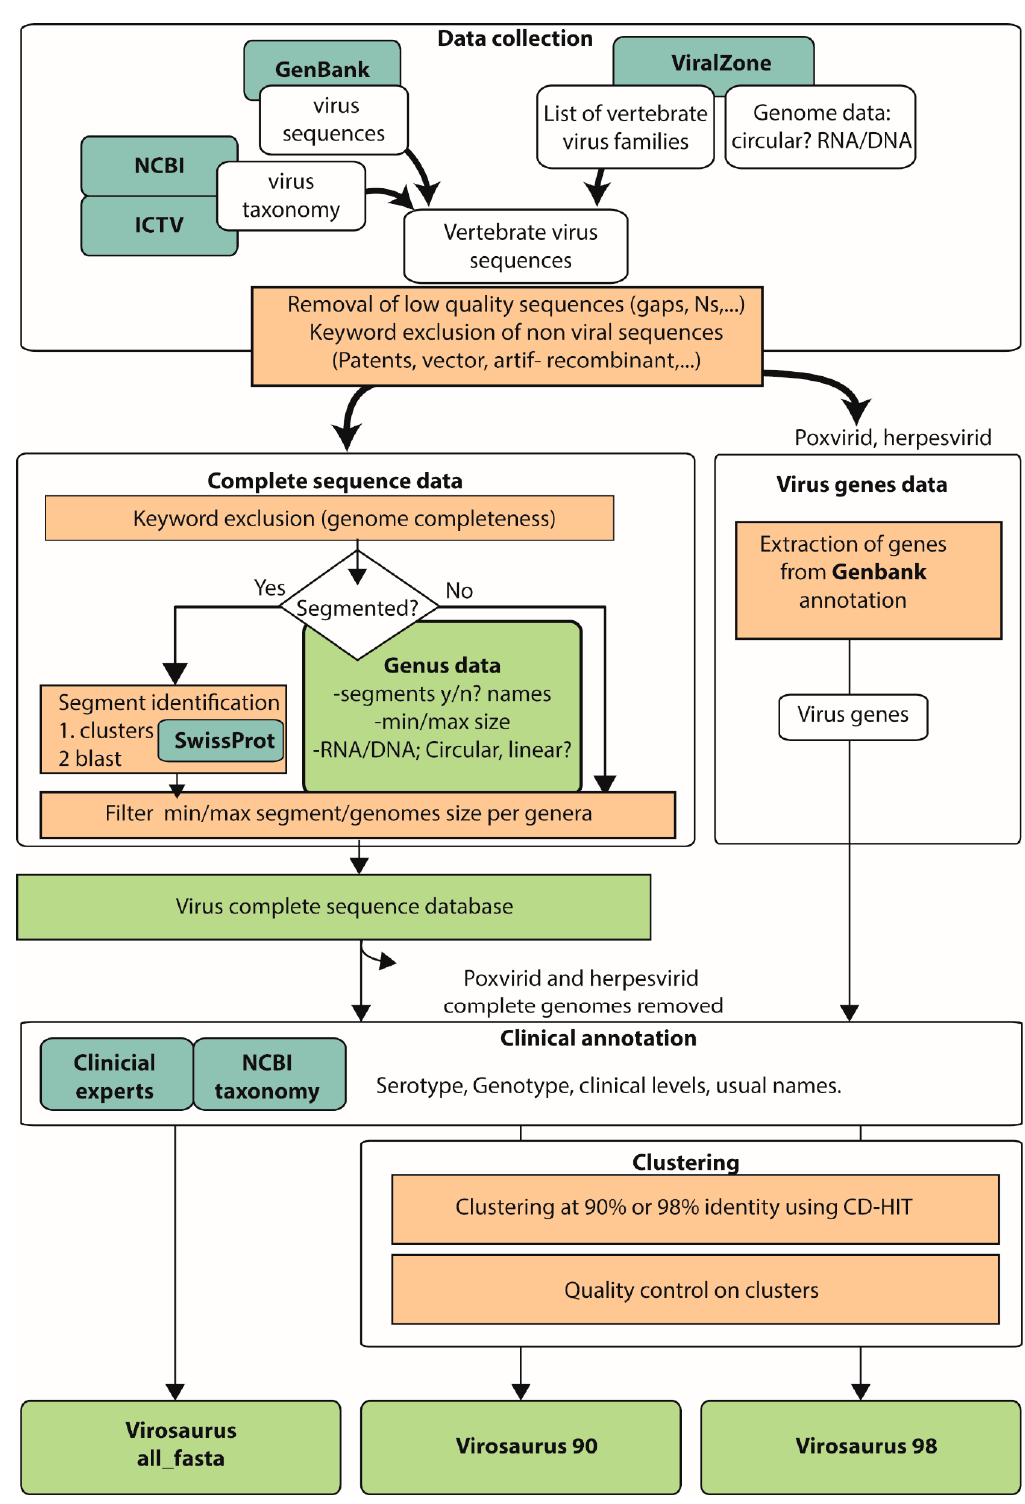
Figure 1. Workflow for the creation of the Virosaurus datasets. References are in blue, and output datasets are in green.